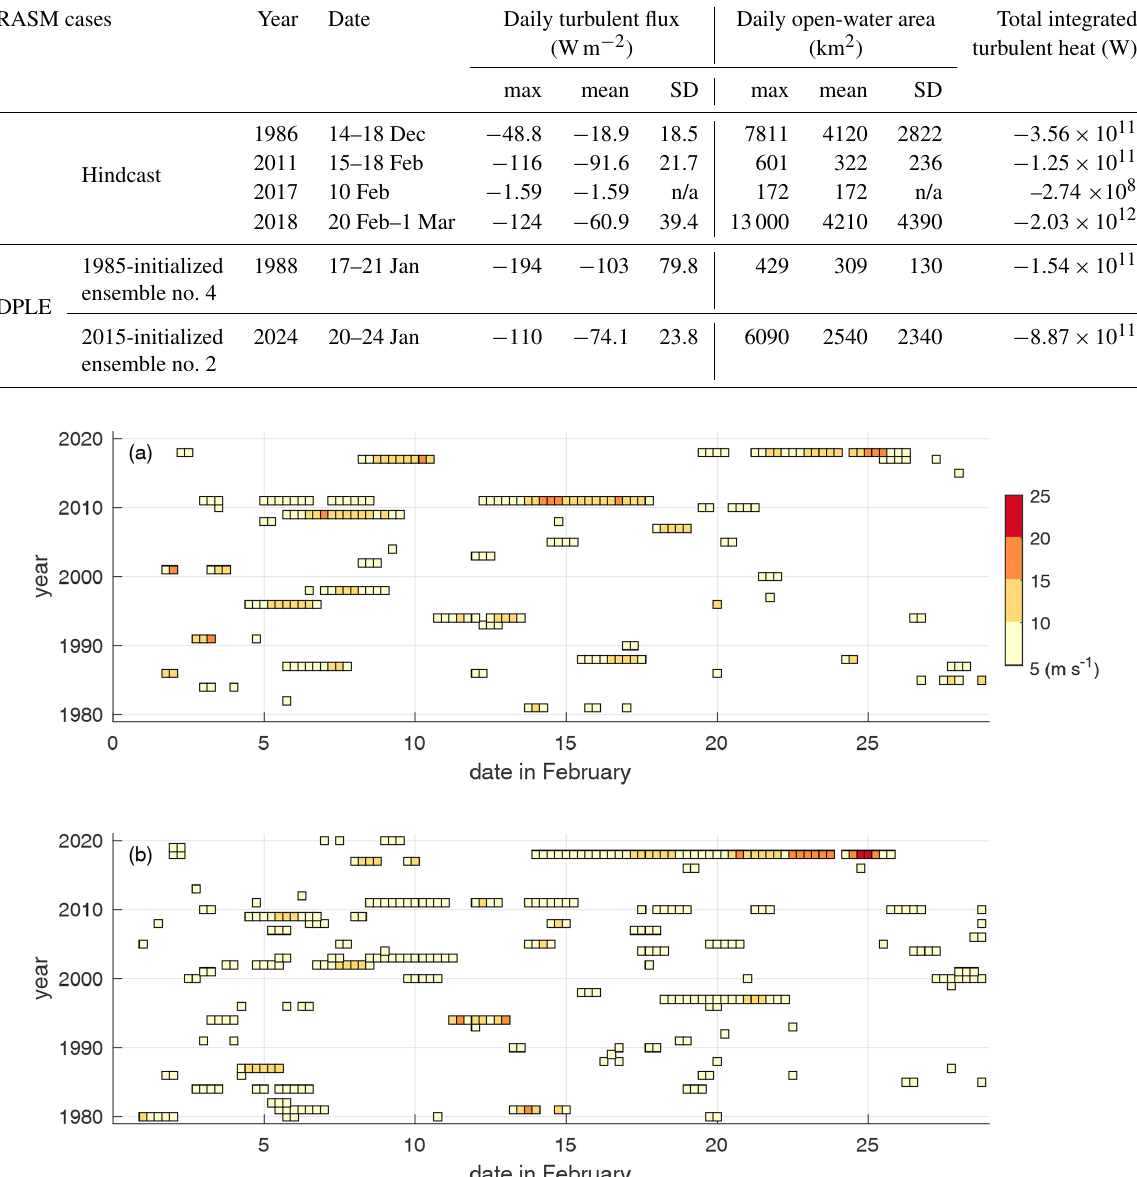
Table 2. Daily mean net turbulent (sensible and latent) heat flux (Wm − 2 ) and its standard deviation (SD) during the polynya events over open-water areas (km 2 ), where sea ice thickness (SIT) is less than 10cm, from the RASM hindcast and DPLE simulations. The negative values indicate heat loss from the polynya to the atmosphere. n/a – not applicable.